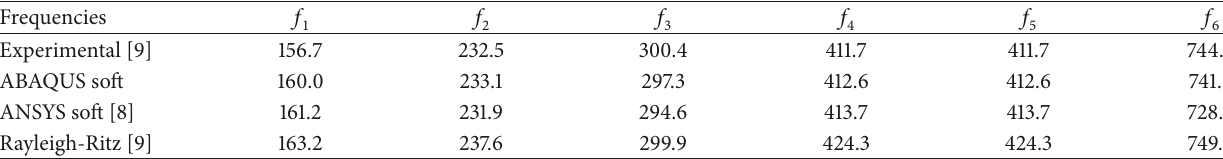
Table 1: Natural frequencies (Hz) of the aluminum plate.